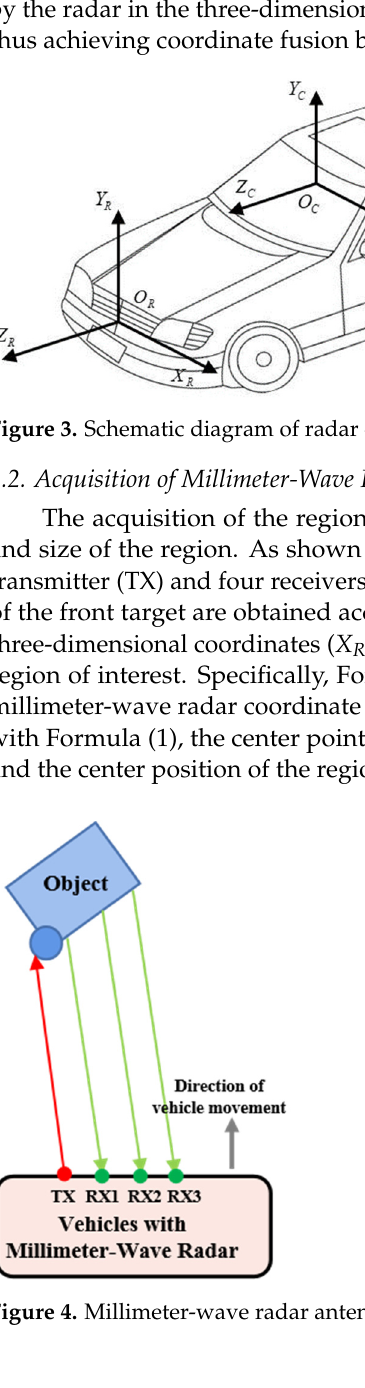
Figure 5. Radar detection target is projected on the image. Figure 6. Schematic diagram of perspective transformation.